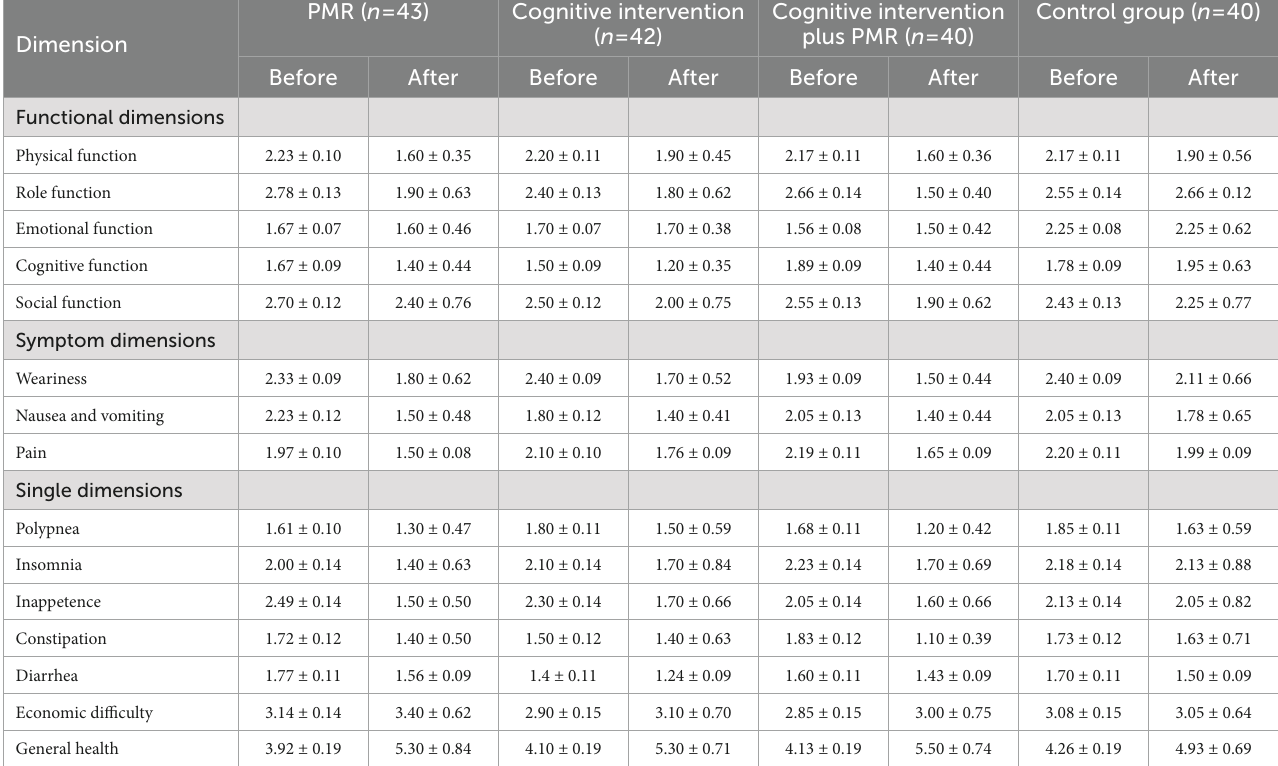
PMR, progressive muscle